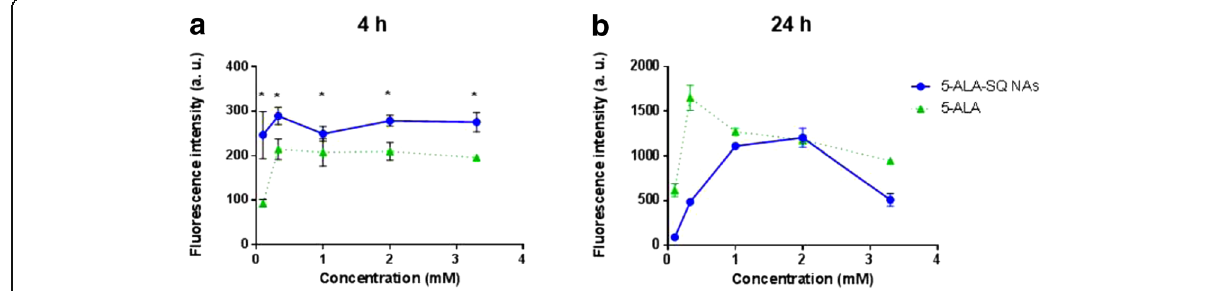
Fig. 6 Dose-response curves. Concentration-dependent PpIX accumulation in U87MG cells after 4 h ( a ) and 24 h ( b ) incubation with 5-ALA-SQ NAs (blue) and 5-ALA